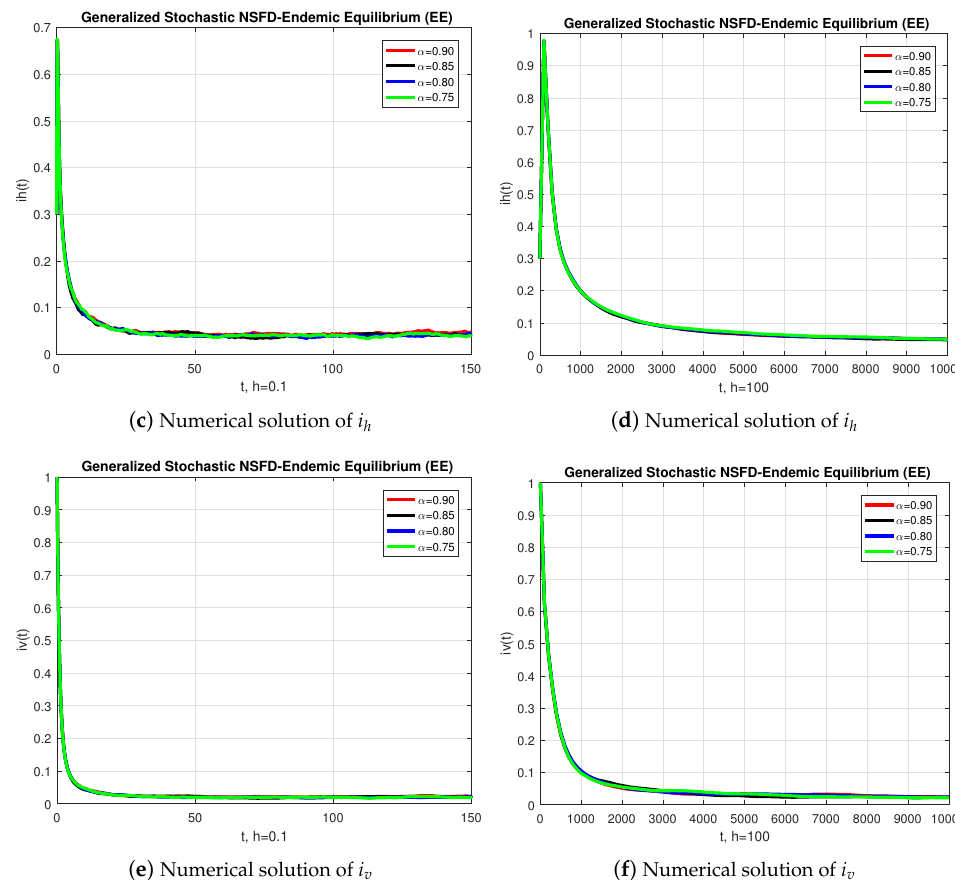
Figure 3. The graphical behavior of each sub-population is presented for two sets of numerical experiments (left and right columns) with different values of α , using the generalized fractional stochastic